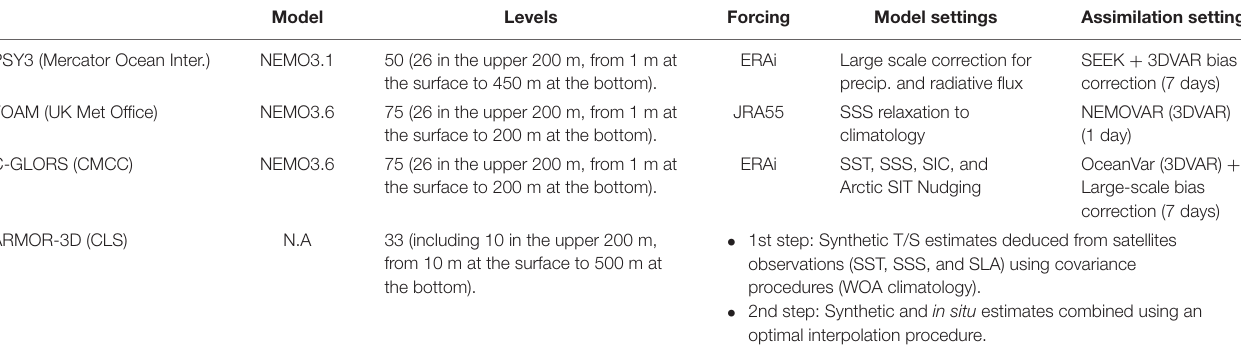
TABLE 1 | Characteristics of the three data assimilation systems (PSY3, FOAM, and C-GLORS) and the statistical merging technique